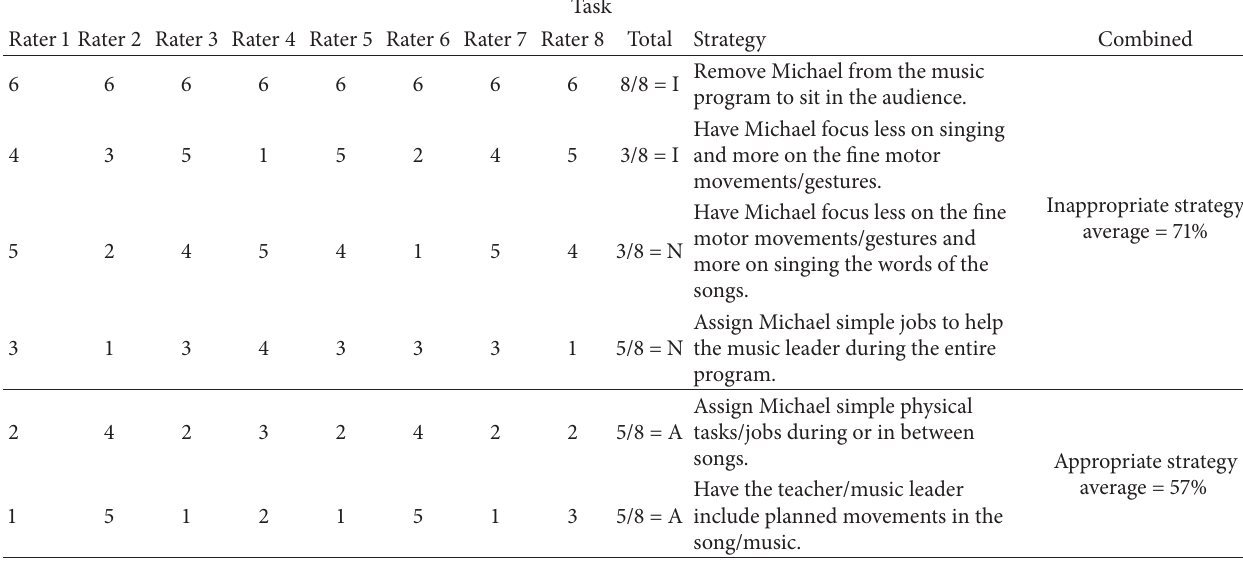
Table 2: Expert ratings for strategies listed for the Task element in A SECRET.